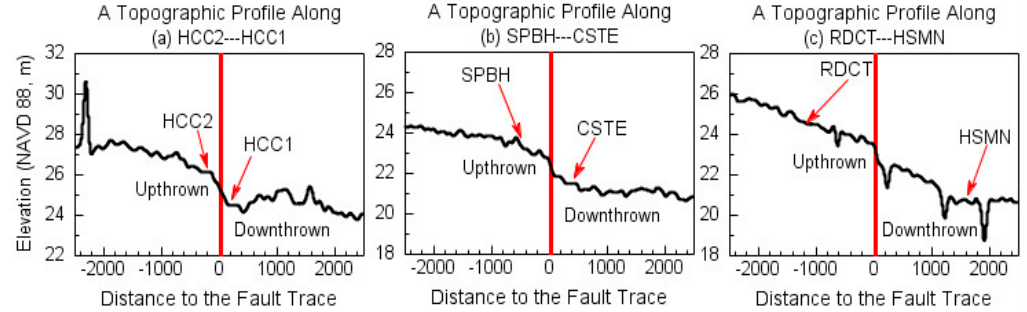
Figure 4. Topographic profiles extracted from the LiDAR-derived DEM: ( a ) along HCC2 and HCC1, ( b ) along SPBH and CSTE, and ( c ) along RDCT and HSMN. The red lines indicate the location of the fault trace of the Long Point Fault. The length of each profile is 5 km (see Figure 2). The LiDAR data was collected in October 2001.